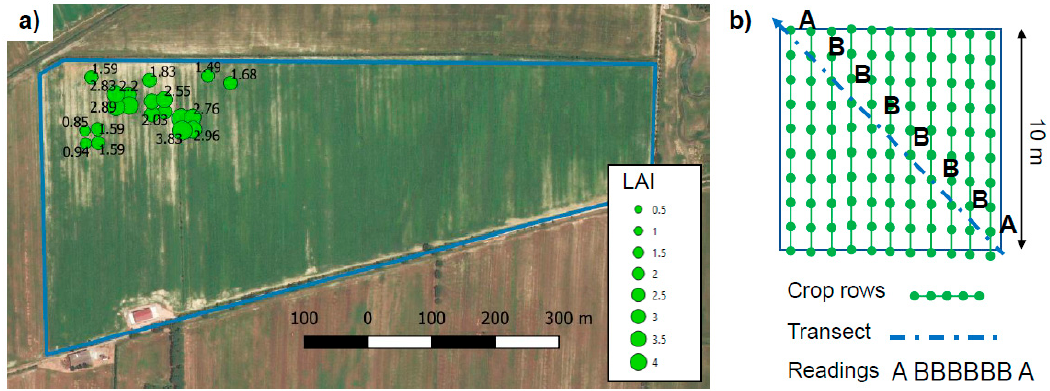
Figure 4. Position and values of LAI measurements available for the analysis ( a ), acquired along a transect on 10 × 10 m plots ( b